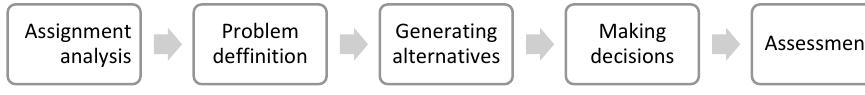
Figure 1. Basic stages of problem solving [43].